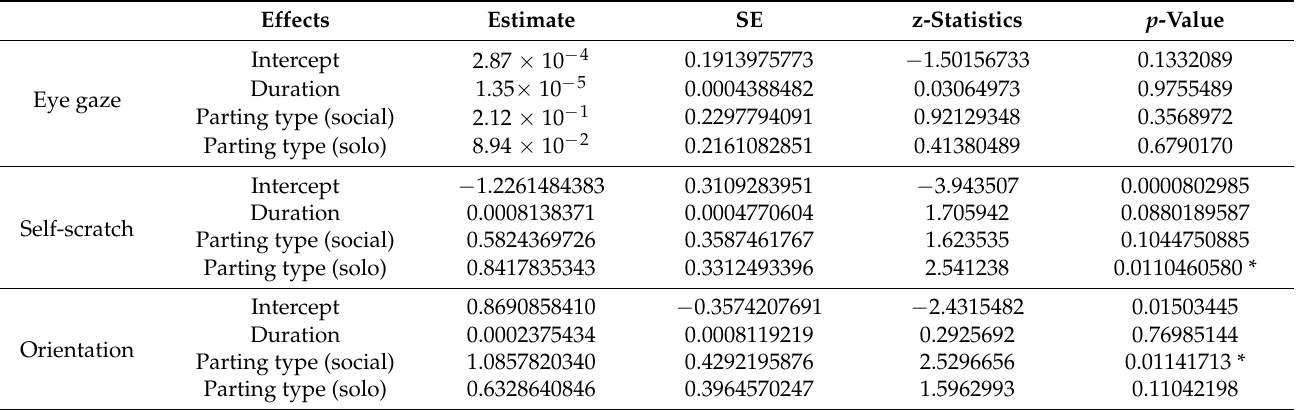
Table 6. Regression parameter estimates for joint frequency